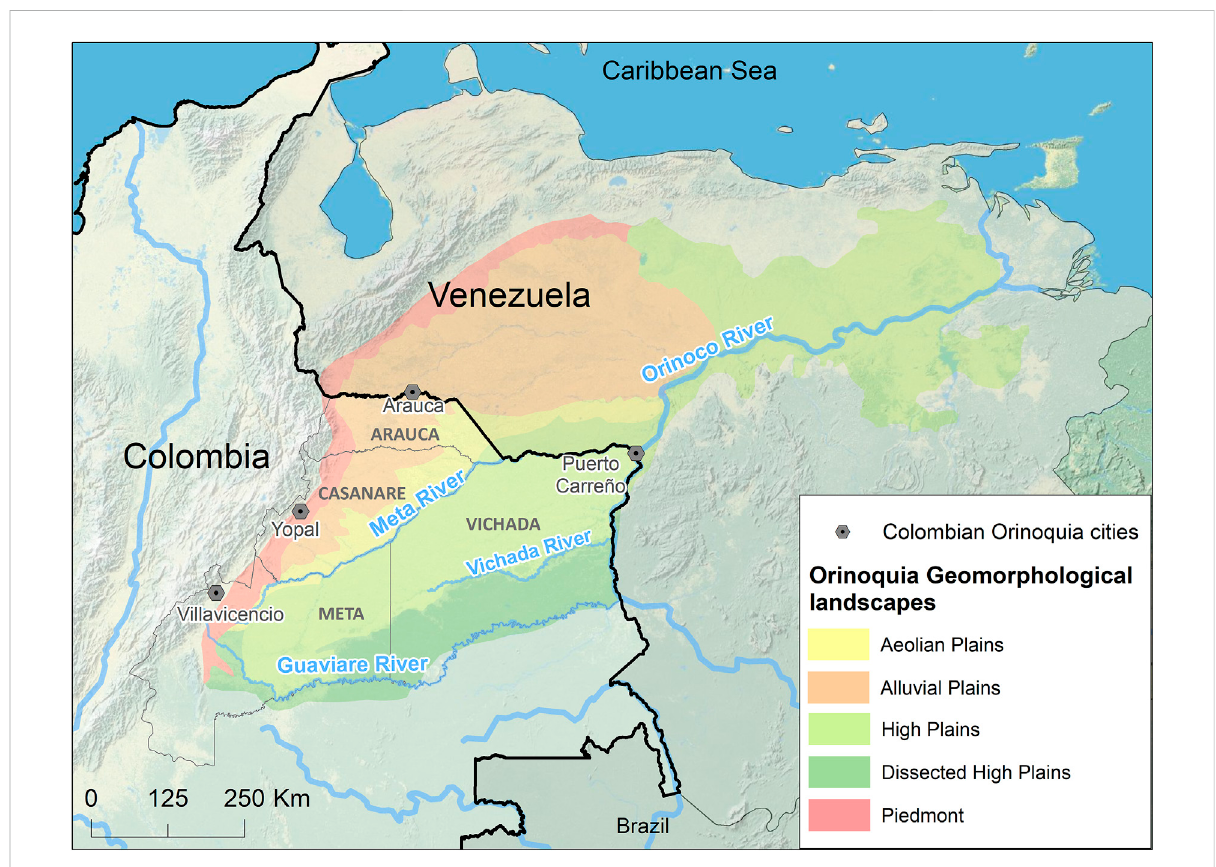
FIGURE 1 A map of the Orinoco River savannas, also known as Orinoquia or Llanos, depicting landscapes, provinces and cities (in Colombia only). Roughly, the Meta River splits the Colombian Orinoquia into the High Plains to the south and a seasonally fl oodable region to the